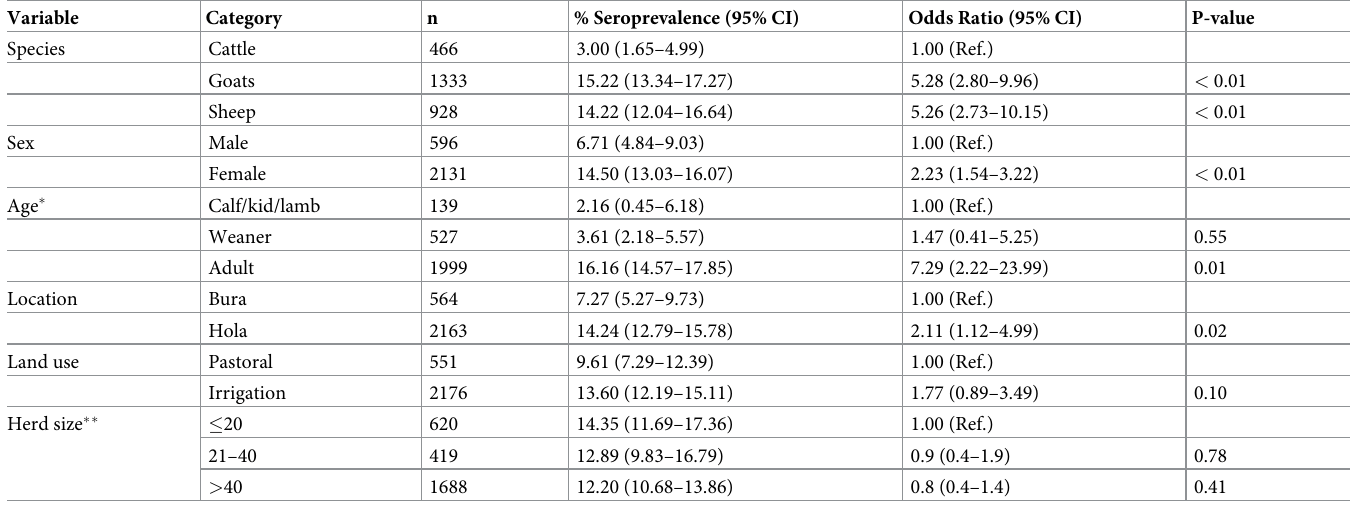
Table 1. Results of variables assessed for their association with C . burnetii seropositivity in livestock using univariable mixed-effects logistic regression models. Variable